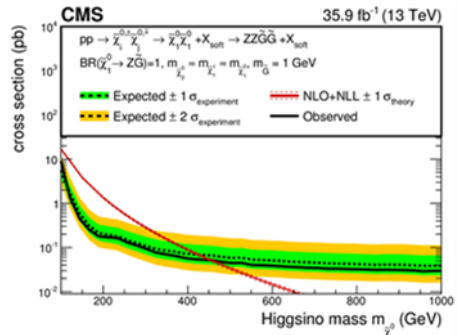
−→ ZZ ˜ G ˜ G model [ 20 ] . ˜ χ 0 1 1